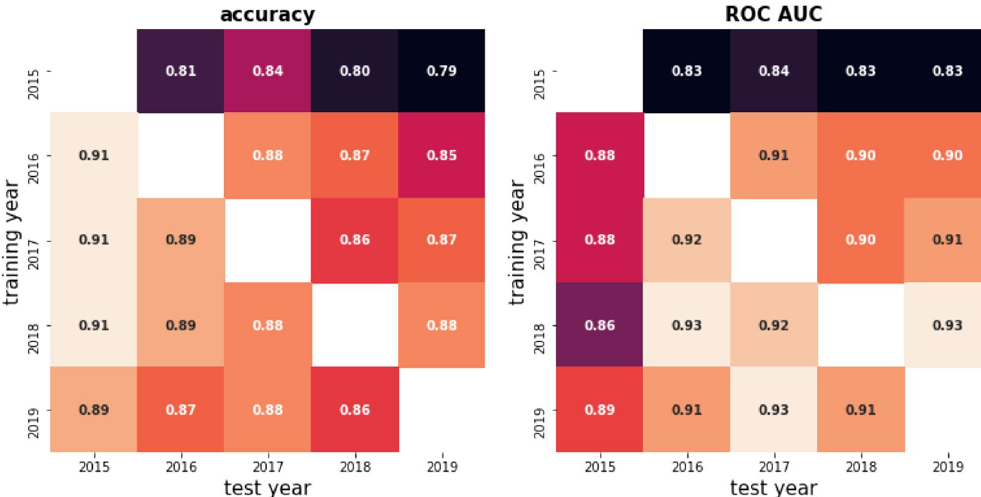
Figure 6. 1000 random samples were selected for each years data. Separated ResNet50 models were trained on each of the years and each model was tested on the rest of the years data. Metrics were calculated with a 500 round random sampling with replacement from the test data. Left: mean of the 500 round bootstrapped accuracy calculations. Right: mean of the 500 round bootstrapped ROC AUC calculations.